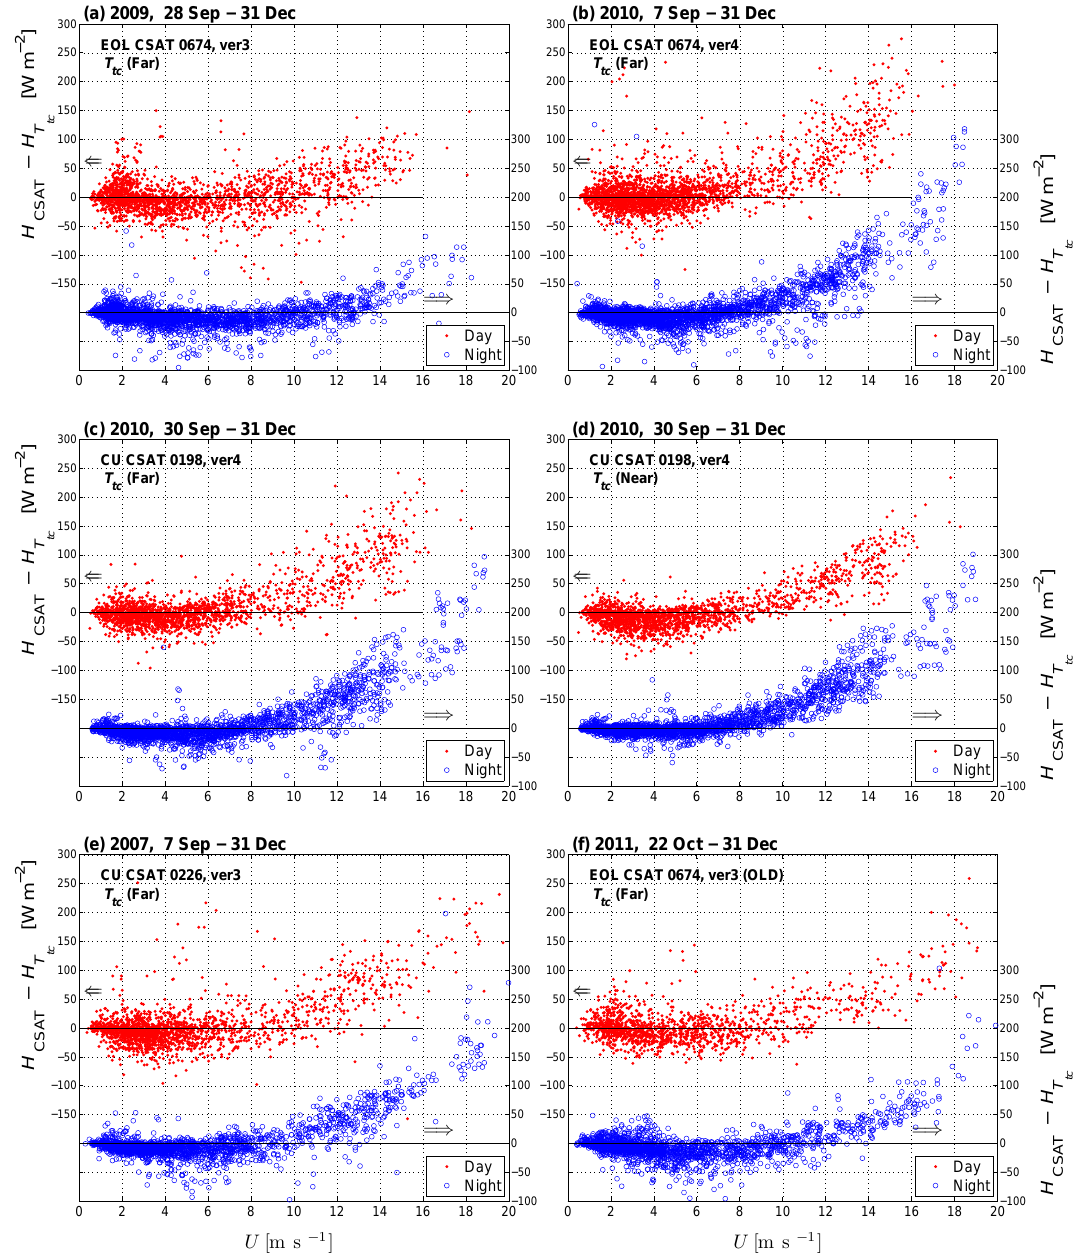
Fig. 2. The sensible heat flux difference calculated with the CSAT and thermocouple ( H CSAT − H T speed U . In (a) – (f) , the time period and the particular CSAT and thermocouple used to determine the sensible heat fluxes are shown in the upper left corner (see Table 1 for sensor details). Each point represents H calculated over 30min, then separated into daytime (left-side axis) and nighttime (right-side axis) periods as shown by the horizontal arrows and legend. EOL CSAT 0674 ver3 is used in both (a) and (f) , but an older set of factory-calibration coefficients is used in (f)